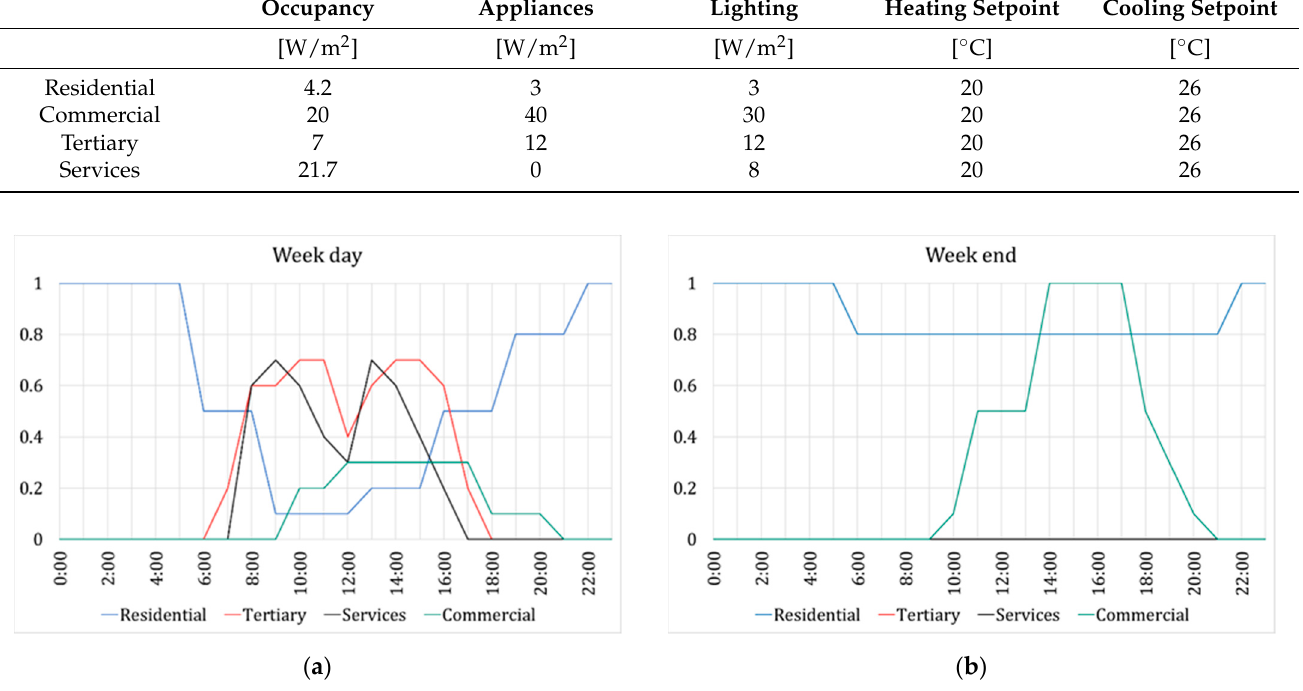
Figure 5. Daily occupancy trend for the considered end-uses: ( a ) week days, ( b ) weekend days, (adapted from [55,56]).